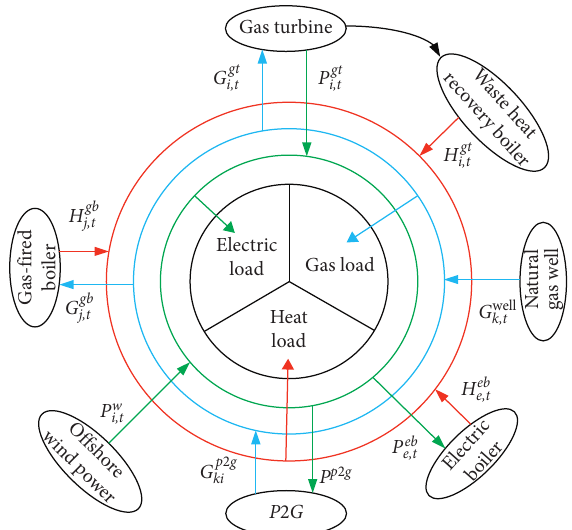
Figure 1: Energy flow of